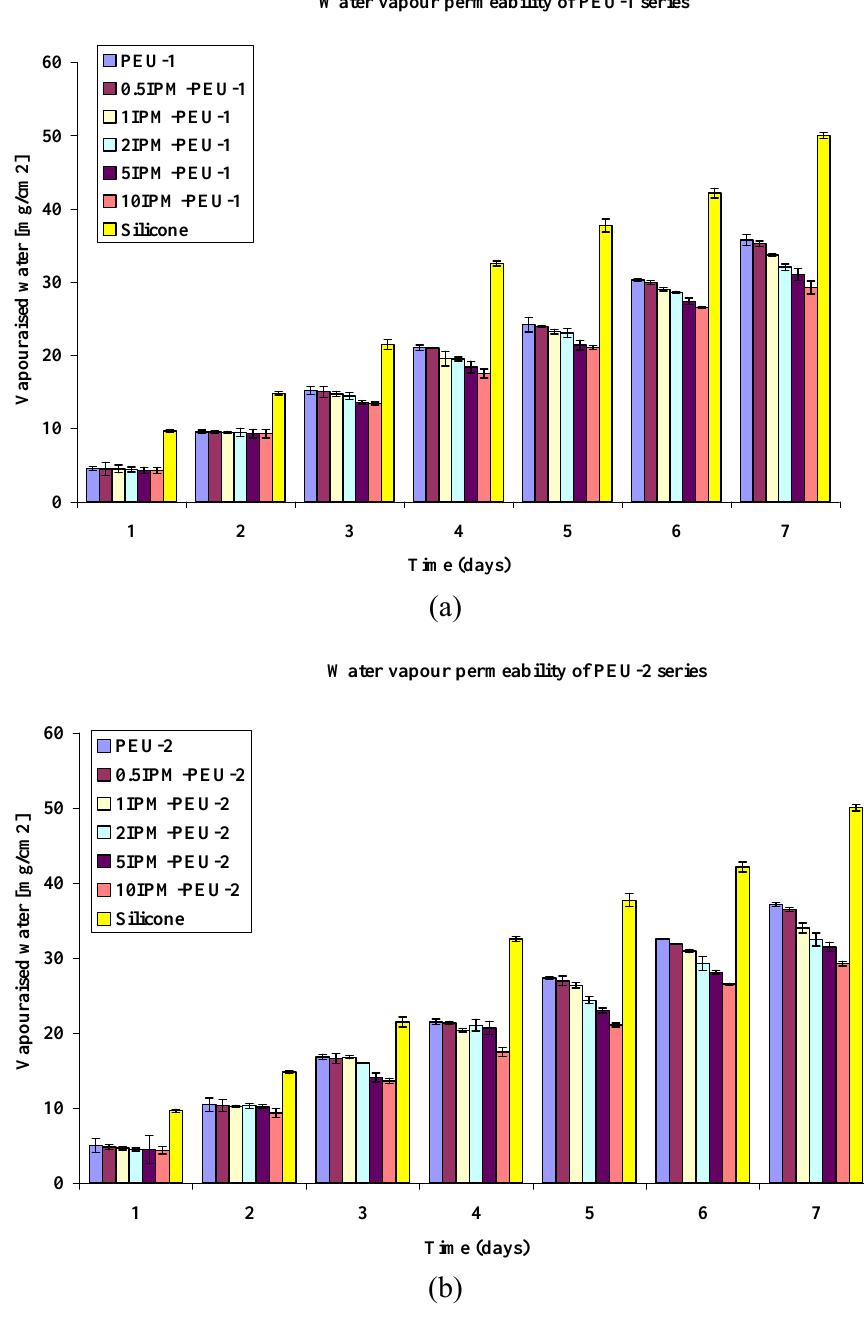
Figure 6. Vaporised water transmission through IPM modified membranes at 25 °C (a) PEU-1 series (b) PEU-2